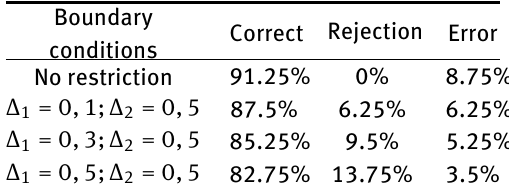
Table 1: Average Results of 8 Folds CV Accuracy Of ANFIS